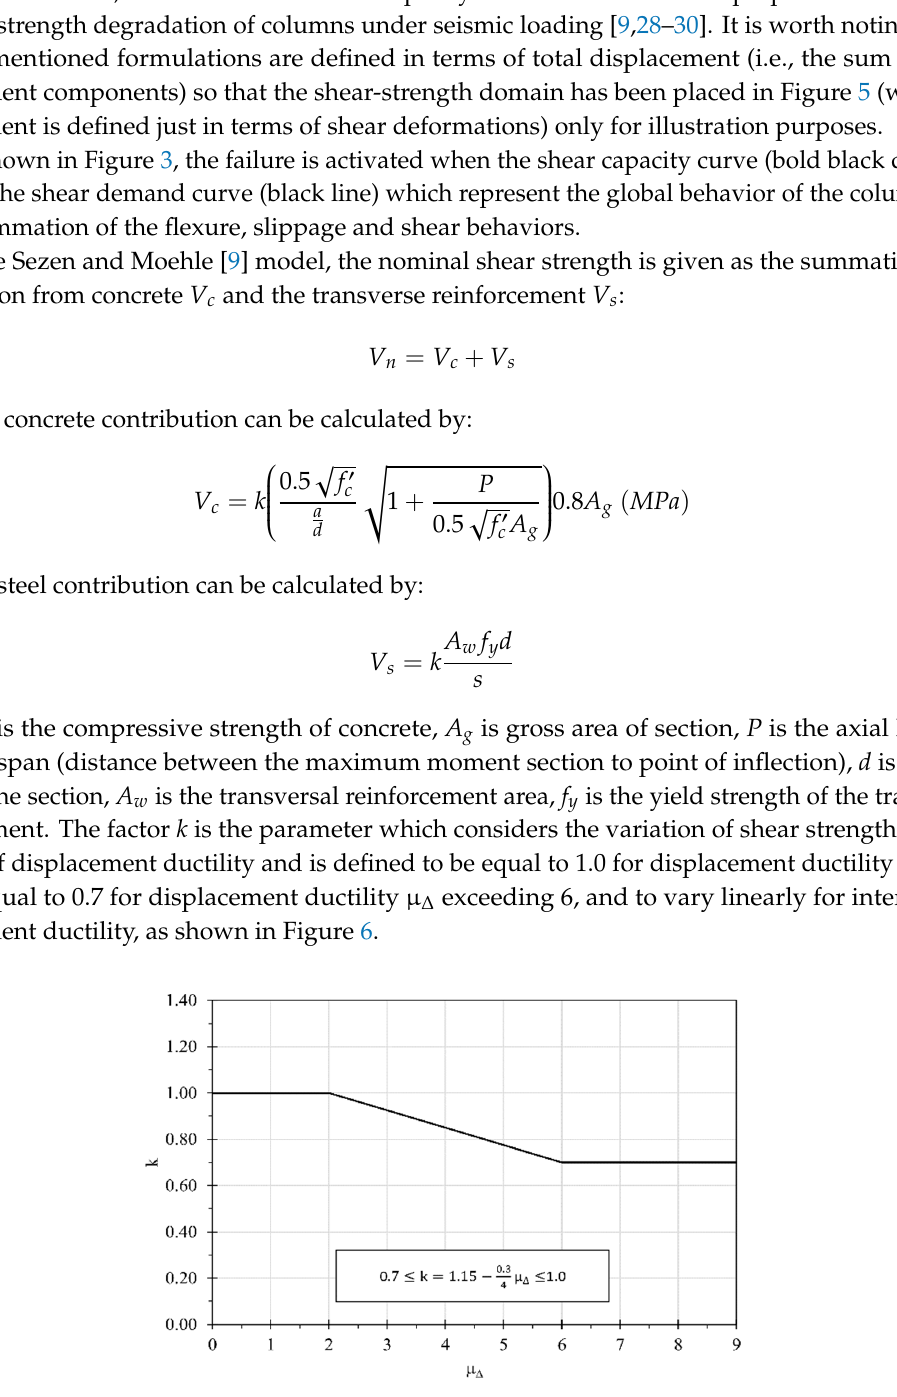
Figure 6. The factor k after Sezen and Moehle [9] (in Equations (7) and (8)).